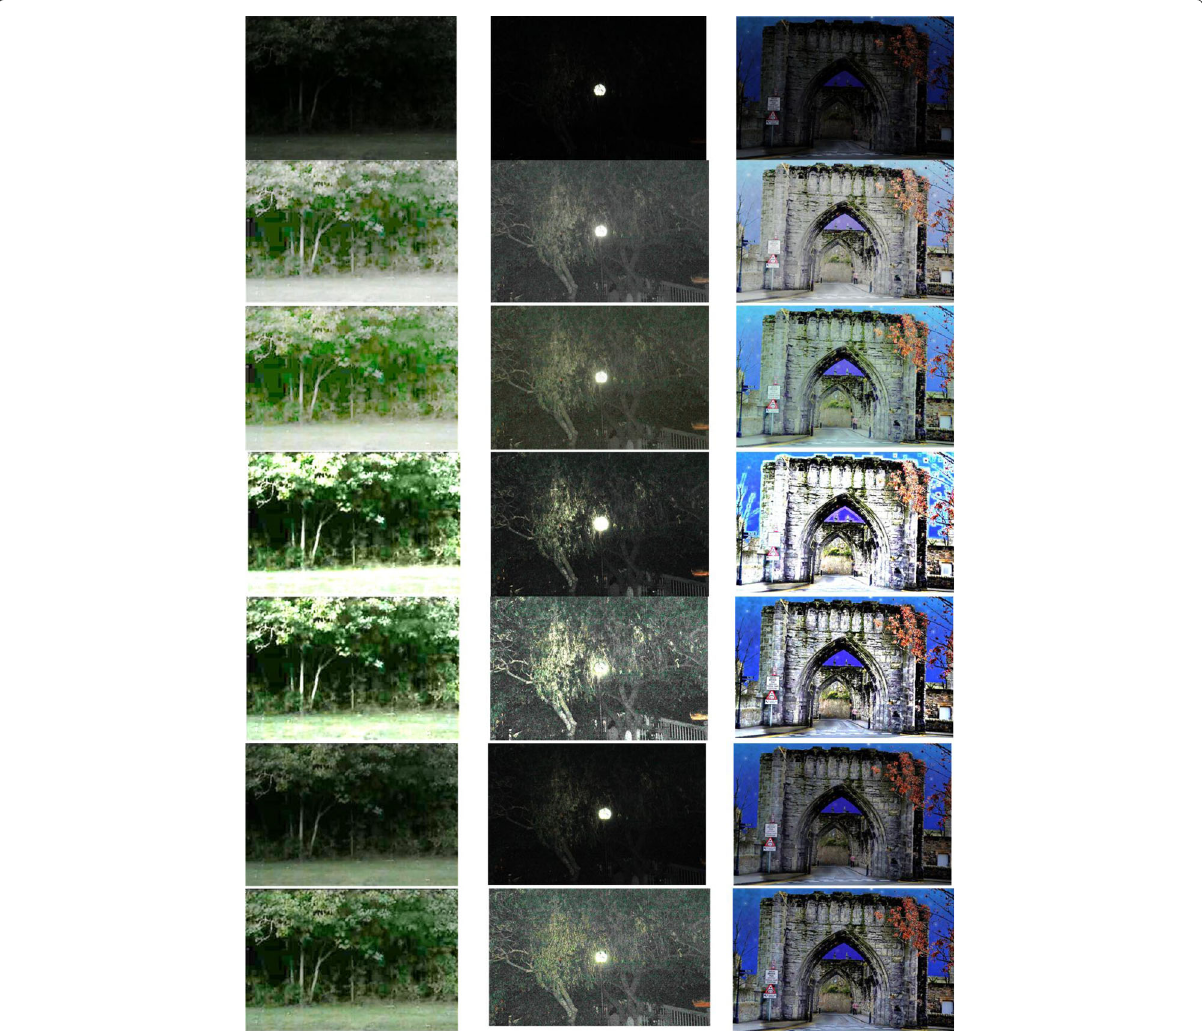
Fig. 14 Comparison of the proposed method with different methods. From top to bottom are original image, results with MSR [11], results with MSRCR [13], results with bright channel prior [21], LIME [23], results with negative dark channel [20], and that with the proposed method